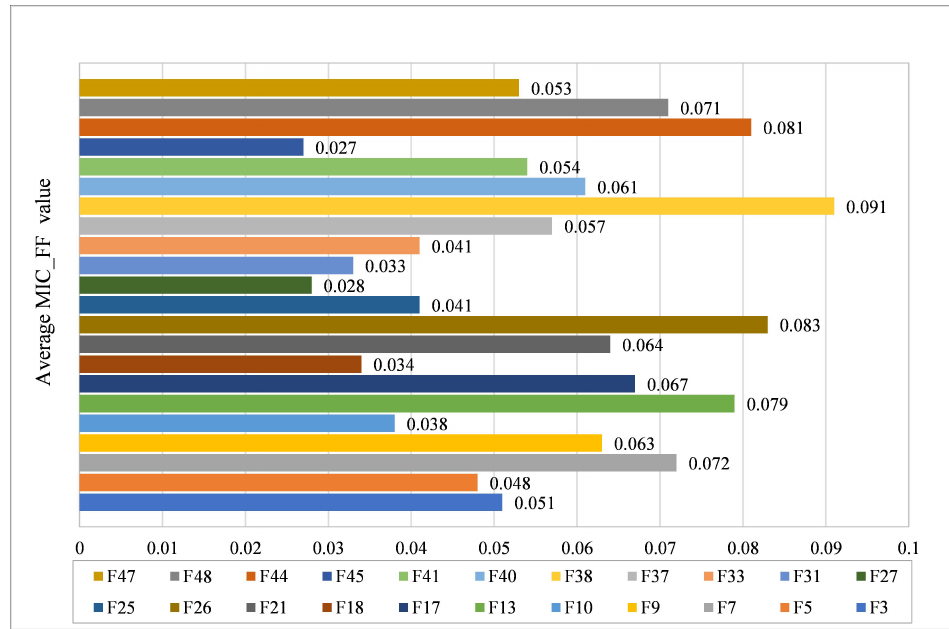
Figure 8. The average MIC FF values of the features in the subset DE MIC FF